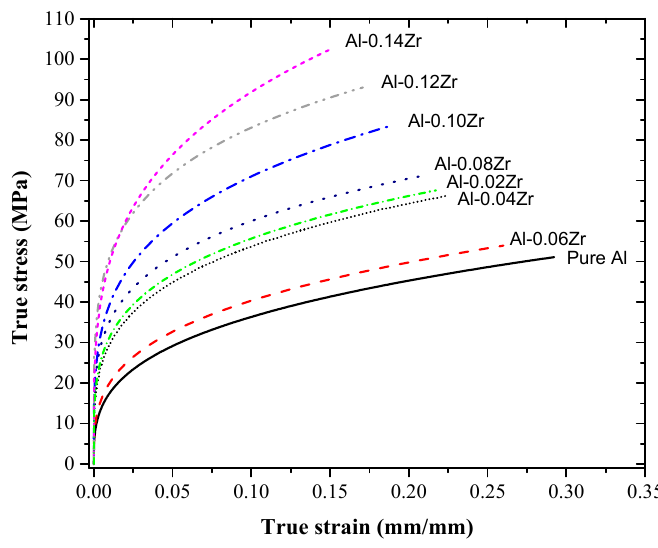
Figure 7. True stress-true strain curves for pure Al and Al-Zr microalloys.